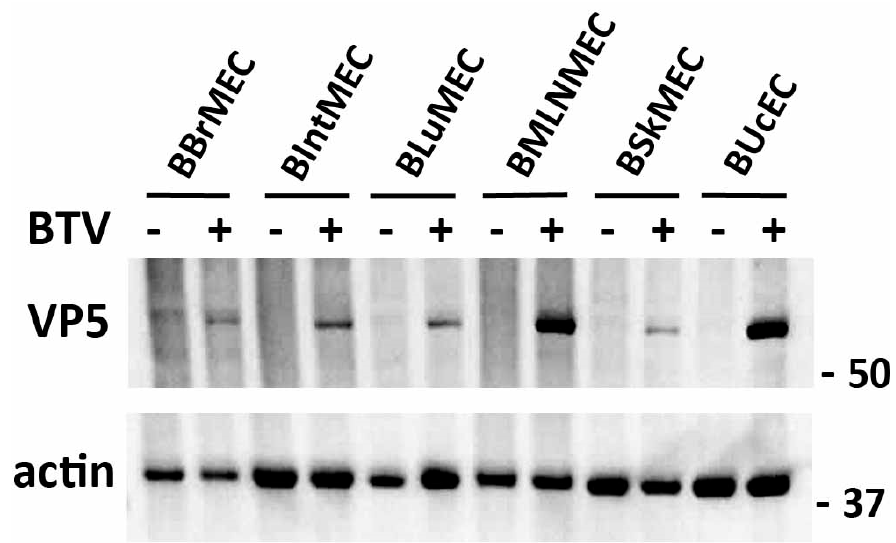
Figure 4. Viral infections of bovine endothelial cell lines by Bluetongue virus (BTV). BBrMEC, BIntMEC, BLuMEC, BMLNMEC, BSkMEC, and BUcEC were infected with BTV (multiplicity of infection (MOI) = 0.1). After 18 h, BTV infection was assessed by anti-VP5 immunoblotting and actin was used as a loading control in Western blot analysis. Originals of Western blot pictures are presented in Figure S1.